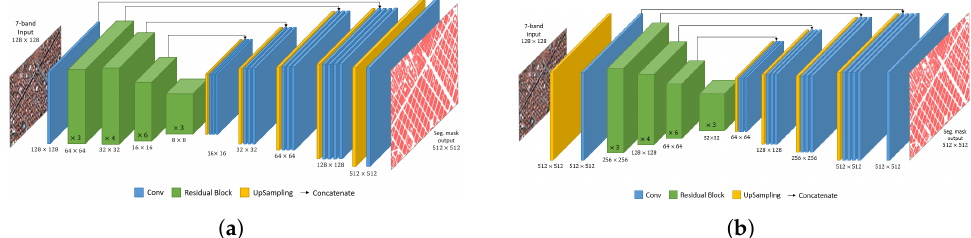
Figure 3. U-Net + ResNet34 architecture approaches to enhance output segmentation maps’ spatial resolution. ( a ) Deconvolution (up-sampling at the output). ( b ) Input re-scaling (up-sampling at the